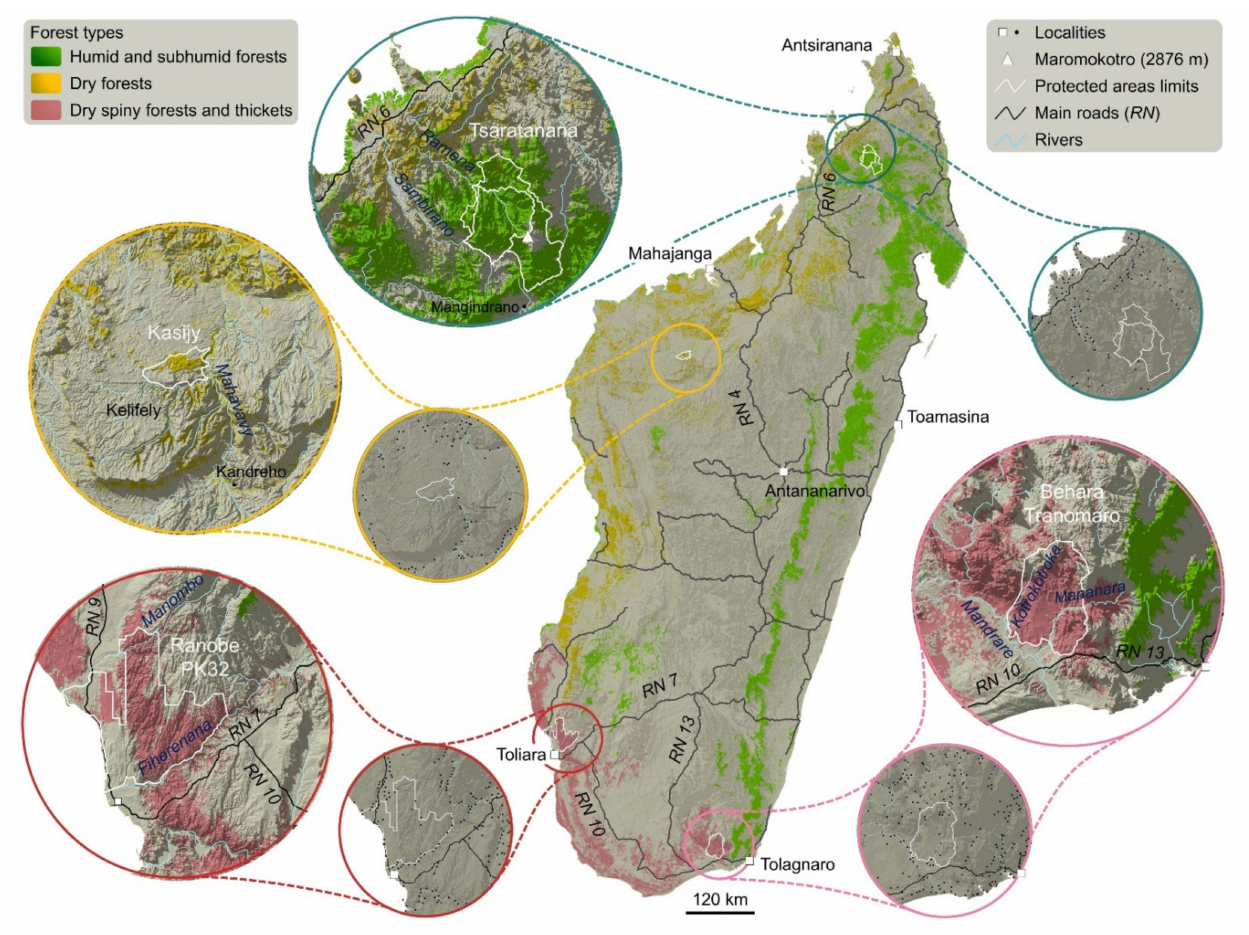
Figure 1. Case study sites. (Simplified forest types according to [17]; circles on the main map with a radius of 60 km, first inset showing the populated places according to the official FTM map BD500, 1:500,000; larger inset with details on